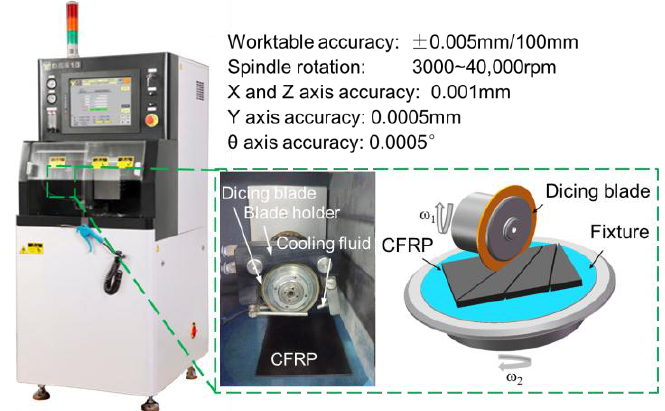
Figure 1. Slicing machine and its parameters. CFRP: carbon fiber reinforced plastic.